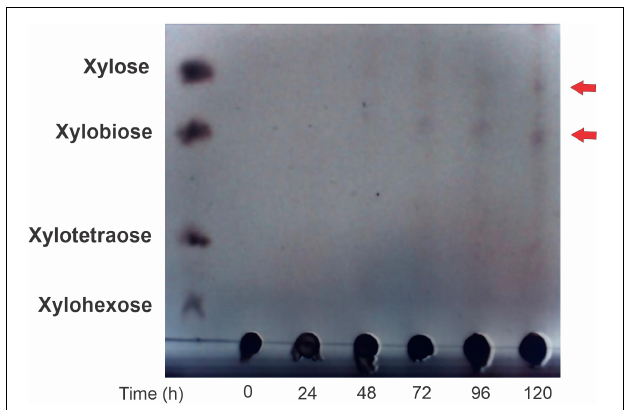
FIGURE 8 | Thin layer chromatography of R13 Fae activity through cinetic time. Enzyme was incubated in 2% (w/v) beechwood xylan in 50 mM buffer citrates pH 6.0 at 25 ◦ C during 0–120